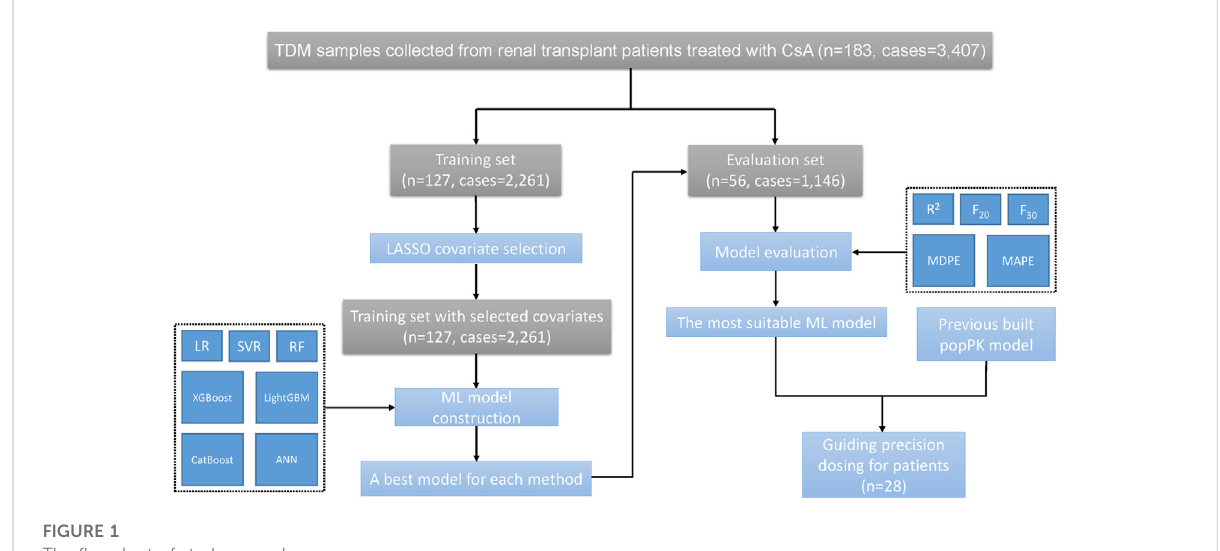
FIGURE 1 The fl owchart of study